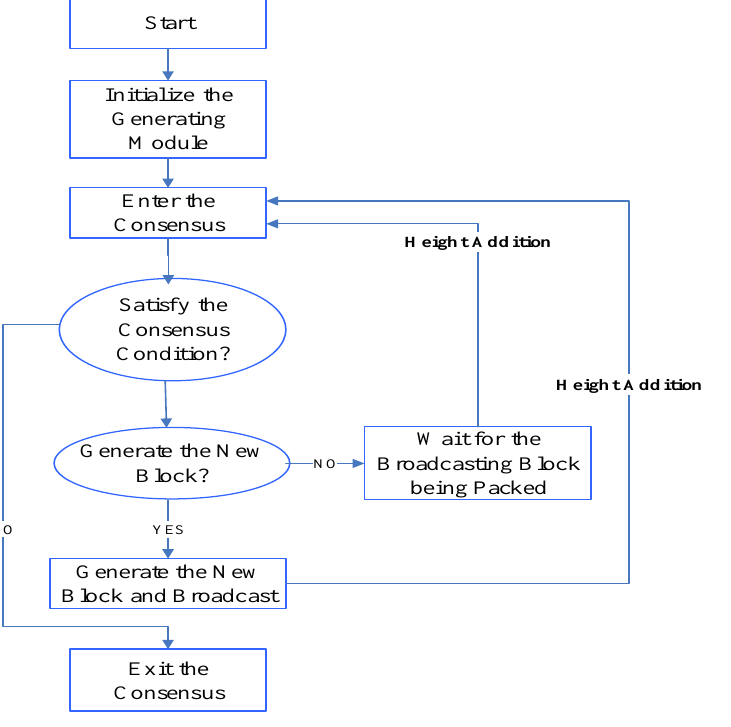
Figure 5. Demonstration of the block-generation process by a consensus algorithm.